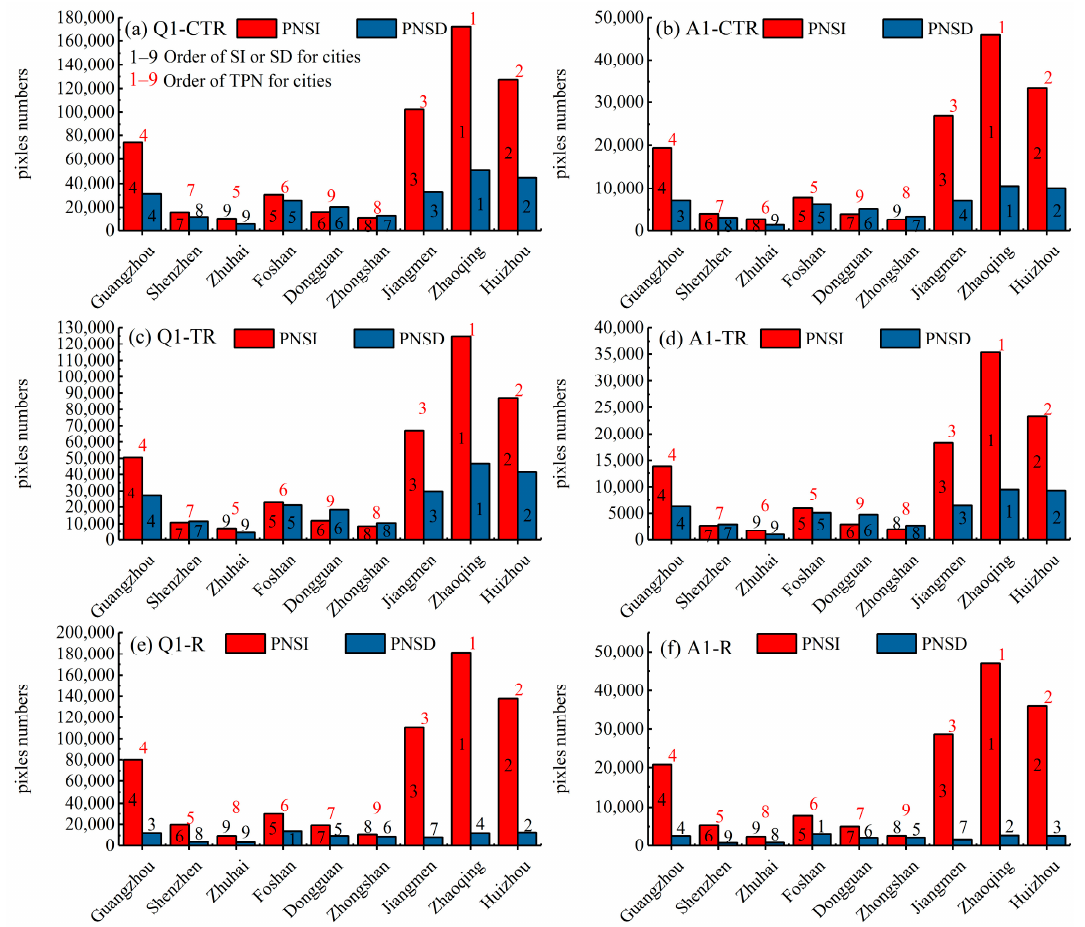
Figure 11. Comparison of the number of pixels of CTSS-RESTREND, TSS-RESTREND, and RESTREND: ( a ) city-scale vegetation change detected by Q1-CTR; ( b ) city-scale vegetation change detected by A1-CTR; ( c ) city-scale vegetation change detected by Q1-TR; ( d ) city-scale vegetation change detected by A1-TR; ( e ) city-scale vegetation change detected by Q1-R; and ( f ) city-scale vegetation change detected by A1-R; PNSI indicates pixel number of significant increase, PNSD indicates pixel number of significant decrease, TPN indicates total pixel numbers.